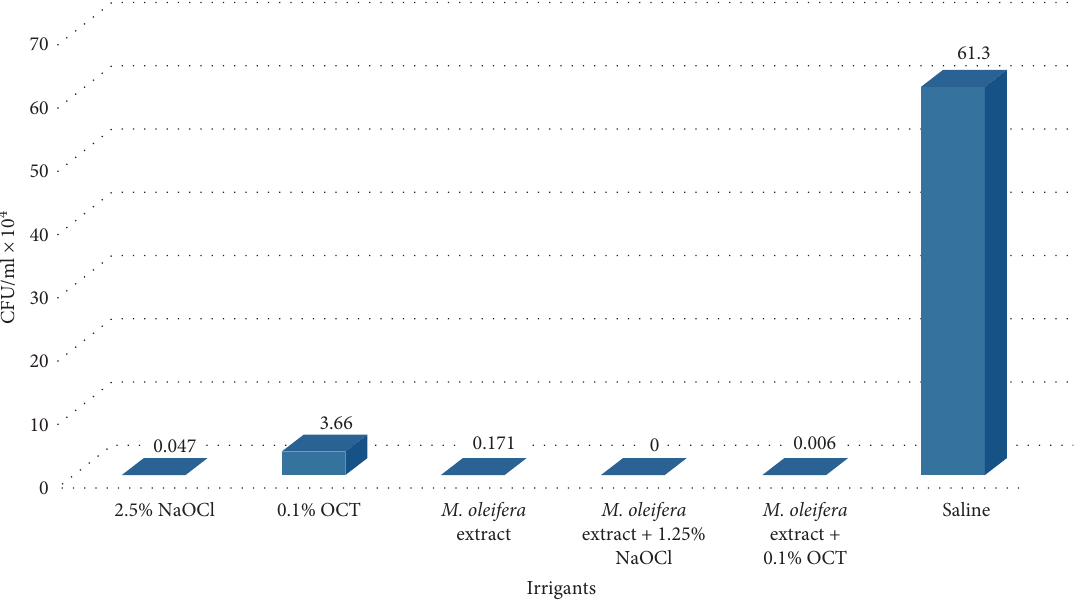
F IGURE 8: The comparison between CFU/ml of E. faecalis in the tested groups after application of the irrigants (CFU-2).